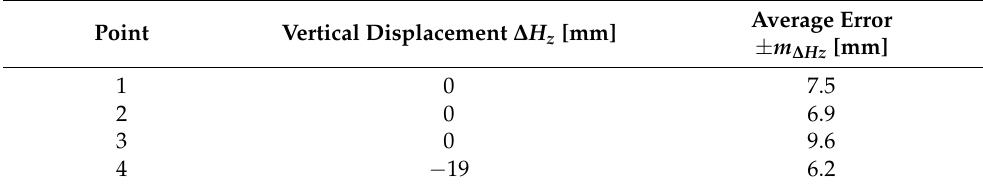
Table 5. Values of vertical displacements of benchmarks I and II segment of the system after the second survey in May 2021 at 3 h